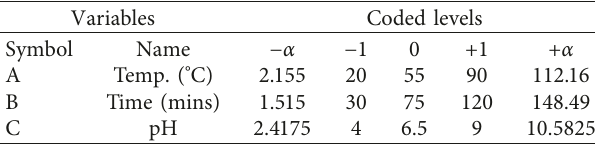
Table 1: Experimental variables and their coded levels for